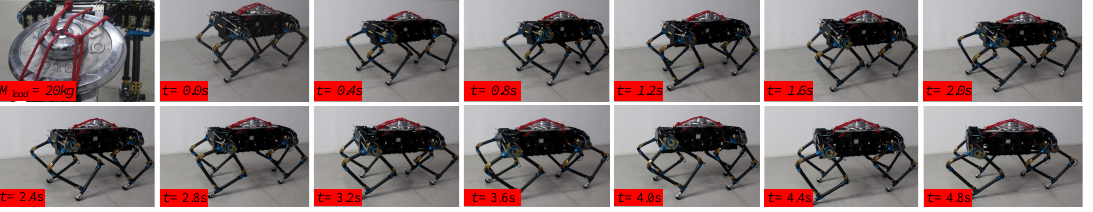
Figure 14. Snapshots of crawling motion with a 20 kg load during the third complete cycle (0.68 km/h).